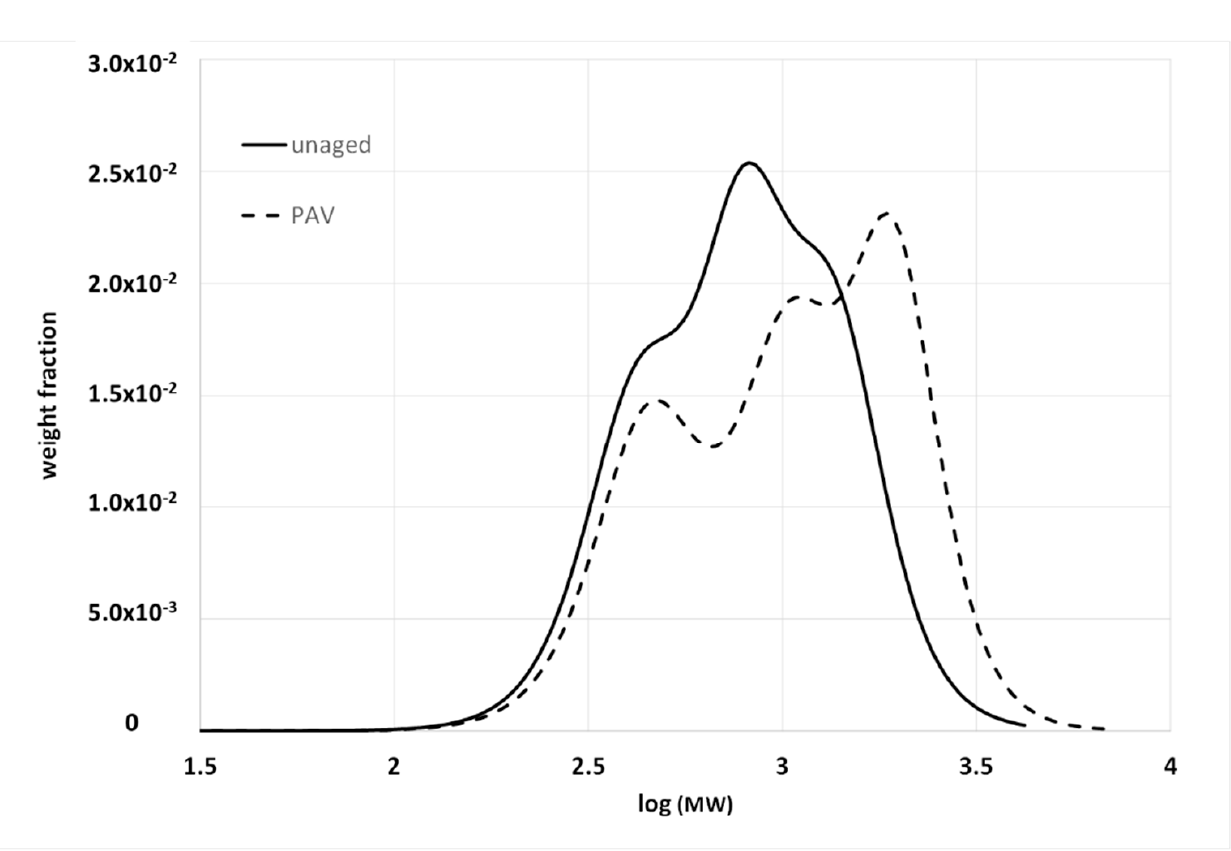
Figure 6. SMWD for a 35/50 Pen-grade base bitumen, before and after being subjected to a pressure- aging vessel (PAV).